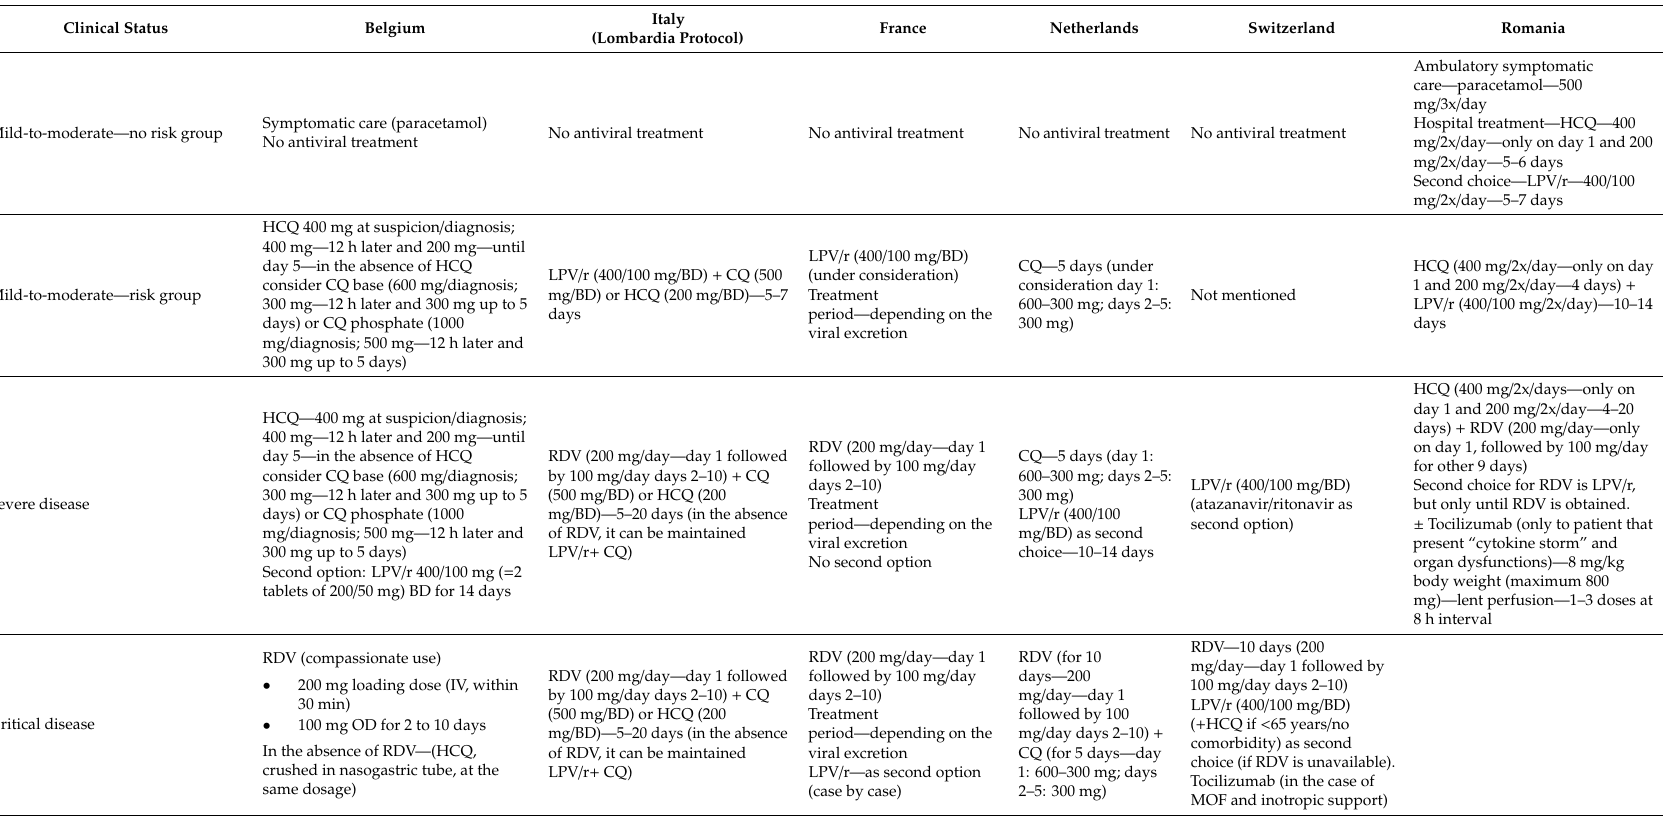
Table 1. Interim coronavirus disease (COVID-19) therapeutic guidelines in di ff erent countries dependent on clinical